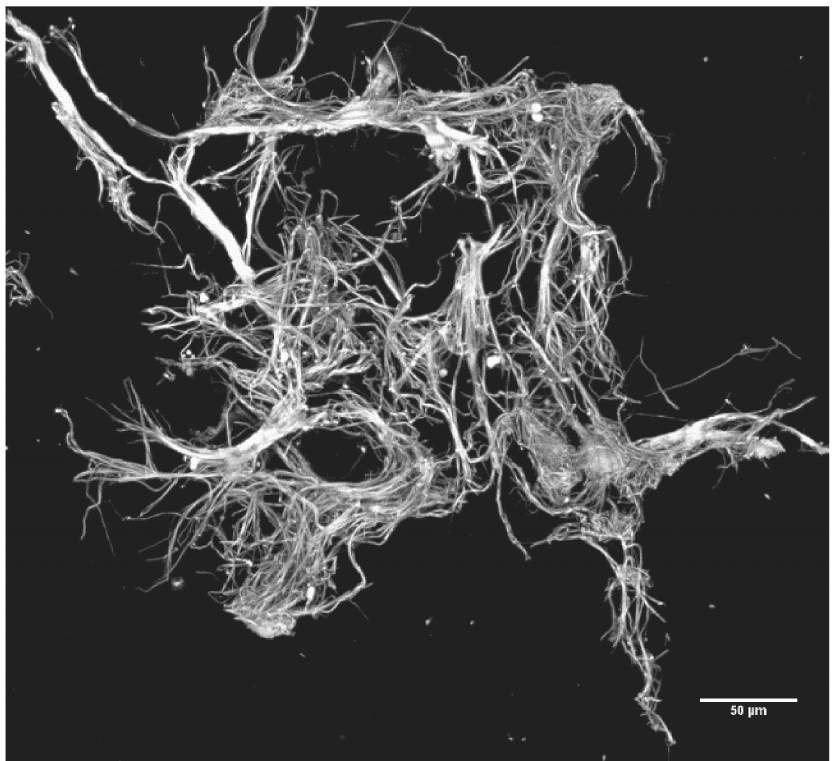
Figure 5. A still larger microclot. Much of the bulk of this clot and that shown in Figure 3 likely formed in the swirling blood rather than on the sieve surface. However, microclots of this size grow even larger when immobilized on the sieve surface as SFMC passing over and through the immobilized clots cause them to rapidly increase in size. Maximum intensity images of 13 z-stacks (6.62 µ m slices). Sypro Ruby Biofilm Matrix stain 20 × air